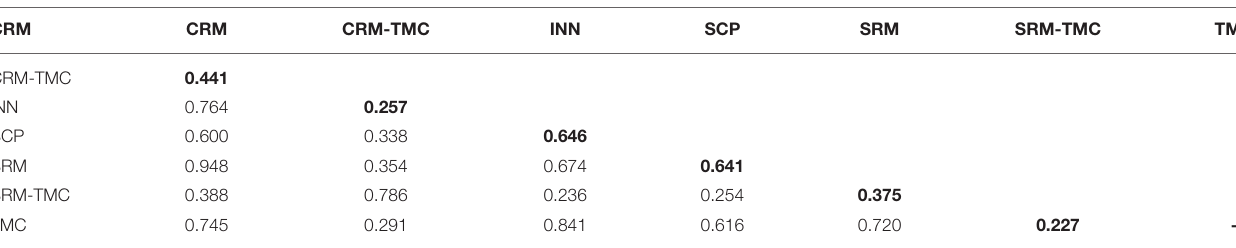
The bold values indicate discriminant validity